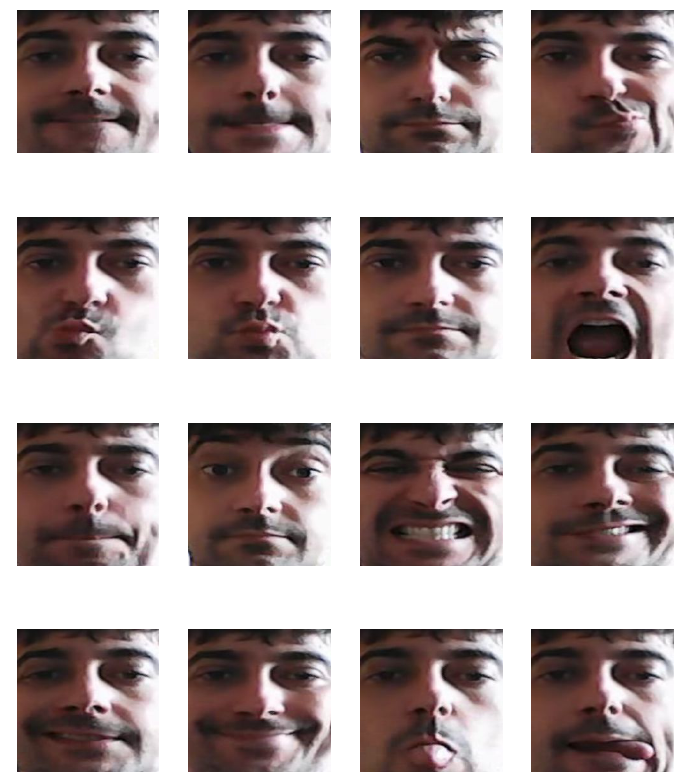
Figure 13. Examples of reference orofacial gesture